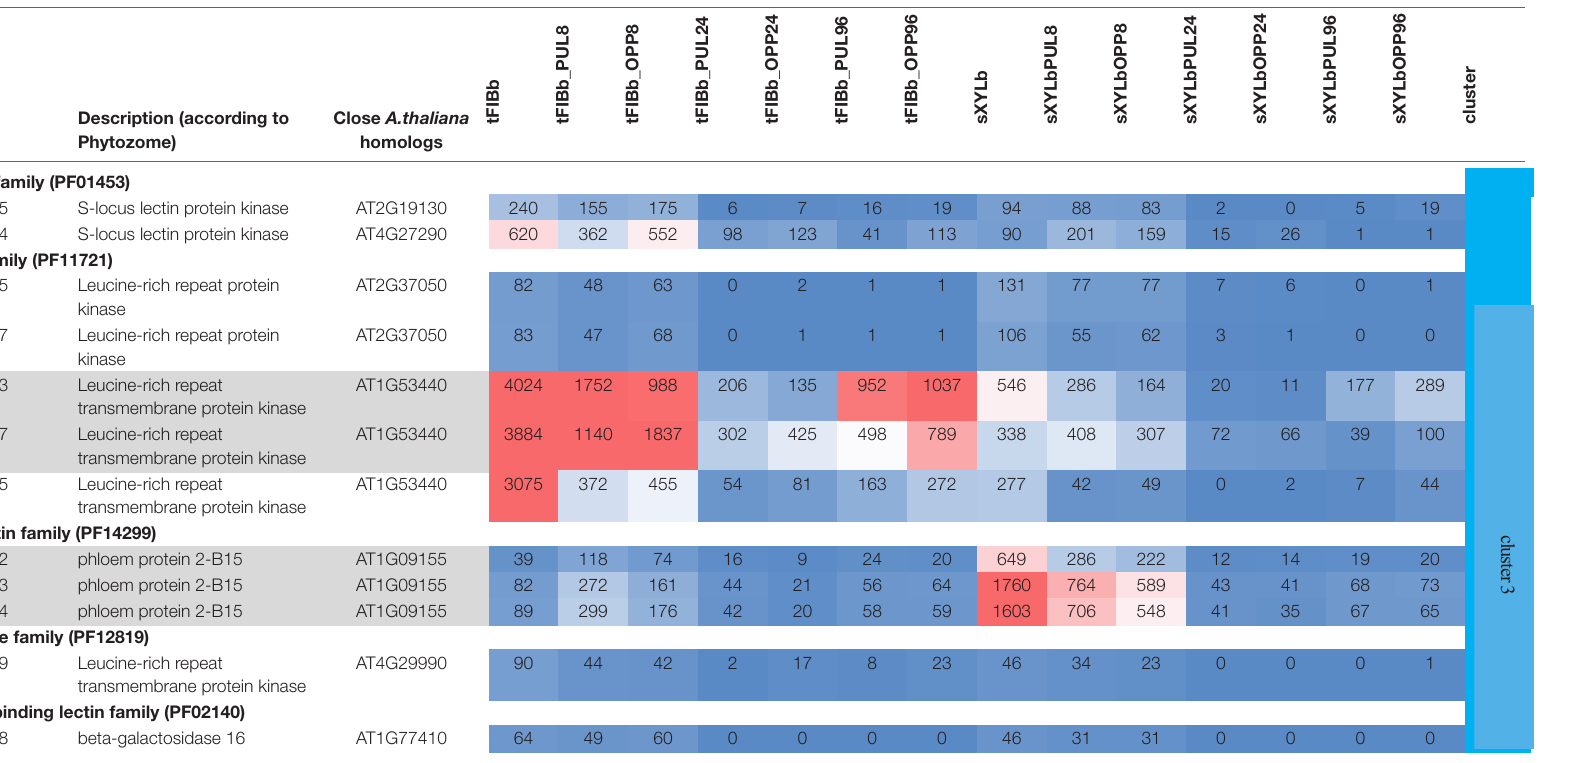
The top 30 genes (TGR ≥ 16 in at least one sample) according to heatmap on Figure 9 . Gene description includes: the gene ID according to the Phytozome v12.1.6 (https://phytozome.jgi.doe.gov/pz/portal.html; Goodstein et al., 2012); the lectin family name that was used in the present study; the Pfam domain by the presence of which lectin family members were distinguished; the gene description according to the Phytozome v12.1.6; Arabidopsis thaliana homologs for genes according to flax genome annotation (Wang et al., 2012). The red-blue heat map indicates the mRNA abundance expressed in TGR values and the color gradient reflects TGR (total gene reads) values from 1 to 1000. Abbreviations: SCW, secondary cell wall; TCW, tertiary cell wall; PM, plasma membrane. tFIBb and sXYLb – isolated fibers with TCW and stem xylem with SCW of non-inclined plant, respectively; tFIBb_PUL8, tFIBb_PUL24, tFIBb_PUL96 – isolated fibers with TCW from pulling side of flax stem after 8, 24, 96 h of gravibending, respectively; tFIBb_OPP8, tFIBb_OPP24, tFIBb_OPP96 – isolated fibers with TCW from opposite side of flax stem after 8, 24, 96 h of gravibending, respectively; sXYLb_PUL8, sXYlb_PUL24, sXYLb_PUL96 – pulling side of stem xylem with SCW after 8, 24, 96 h of gravibending, respectively; sXYLb_OPP8, sXYlb_OPP24, sXYLb_OPP96– opposite side of stem xylem with SCW after 8, 24, 96 h of gravibending. Genes that were considered as differentially expressed ( Tables 4 , 5 ) in the tissues under normal condition are given on a gray